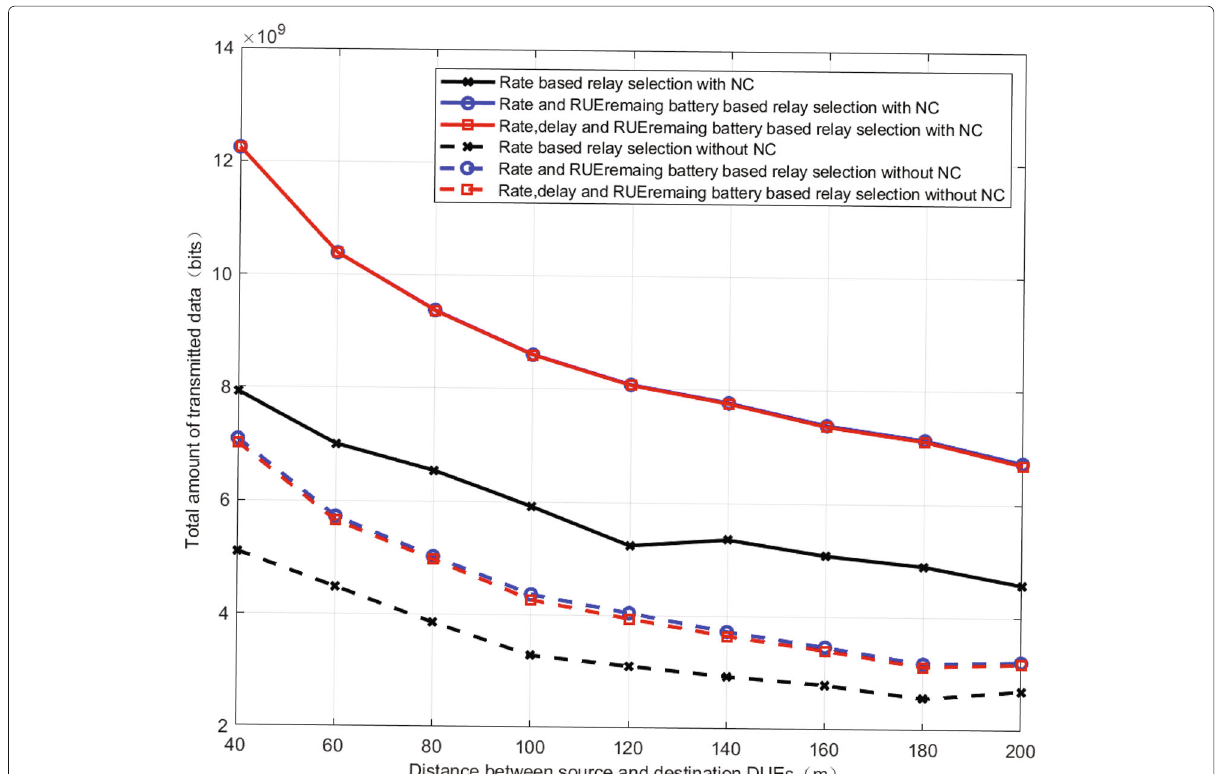
Fig. 6 The total transmitted data of the three relay selection methods with and without network